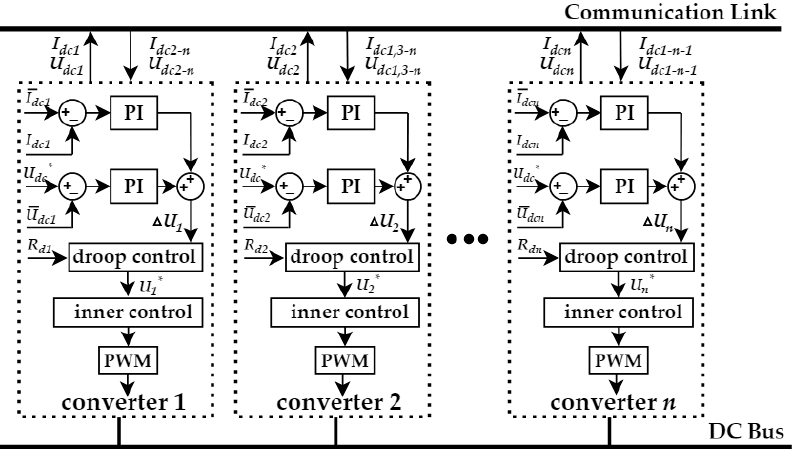
Figure 8. The traditional double compensation hierarchical control algorithm based on the voltage and current deviation. PI: Proportion-integral.